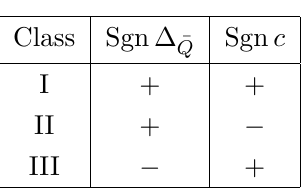
Table 1 . The three classes of solution and their defining characteristics.